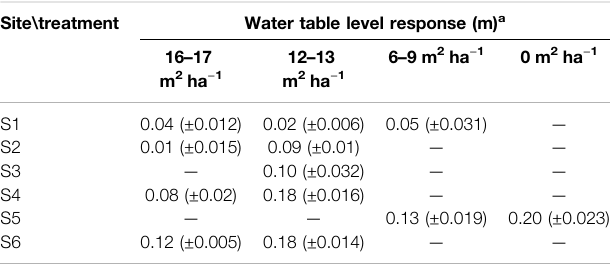
TABLE 3 | Mean water table response to harvest (see Eq. 6 ) at sites S1 – S6 grouped by treatments (i.e., postharvest stand basal area, m 2 ha − 1 ) during June – October. Site\treatment Water table level response (m)